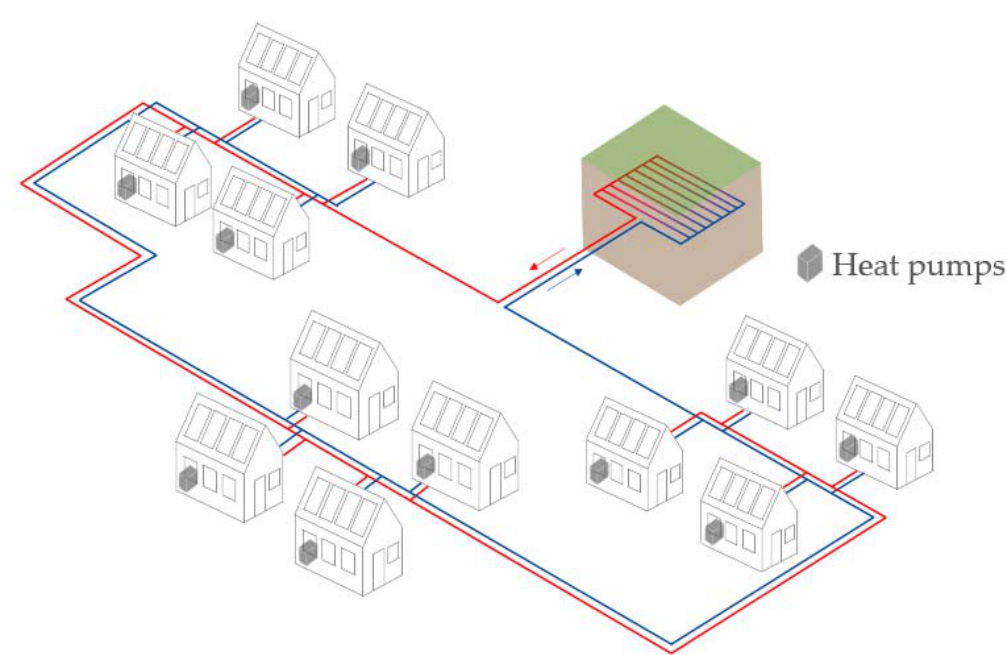
Figure 8. Low temperature district heating (very) shallow geothermal system with horizontal collectors and heat pumps [101] (p. 19).